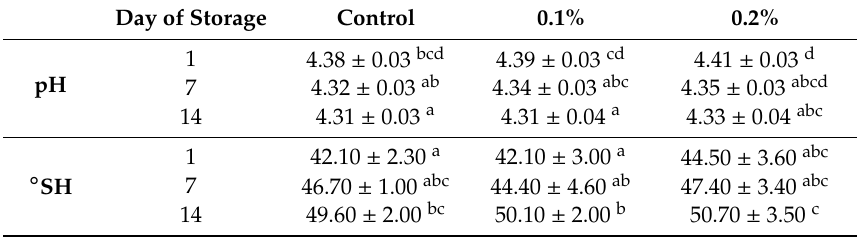
Table 2. Acidity changes in the yoghurt supplemented with of 0.1% and 0.2% ( w / v ) of Rosa spinosissima fruits extract.